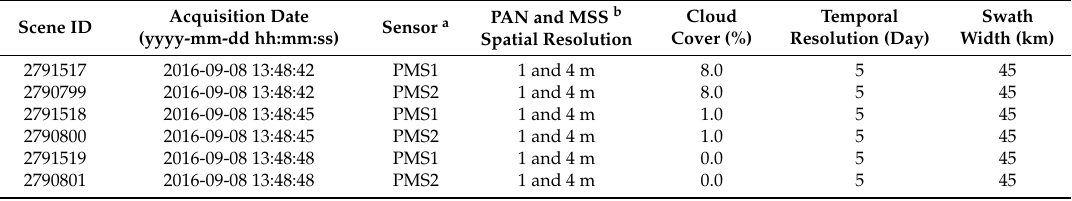
Table 1. GF-2 PMS images used for the extraction of glacial lakes in this study.